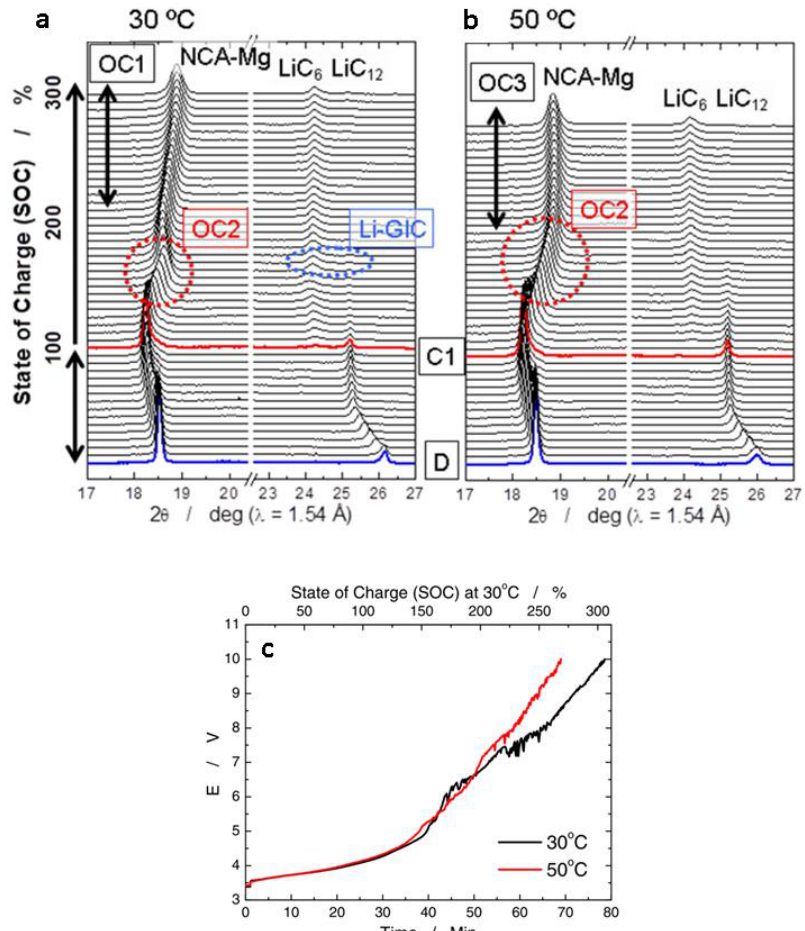
Figure 20. X-ray diffraction patterns for NCA-Mg and graphite during (over-)charging at ( a ) 30 and ( b ) 50 °C. The SOC at 0 and 100% of the lithium-ion cells are shown in blue and red, respectively. ( c ) Voltage profile of NCA/Mg-graphite cells cycled to 10 V at 2C-rate at 30 or 50 °C. The state of charge (SOC) at 100% is defined as 4.1 V terminal cell voltage, and the SOCs at 30 °C are displayed in the figure [197]; with permission of JES.